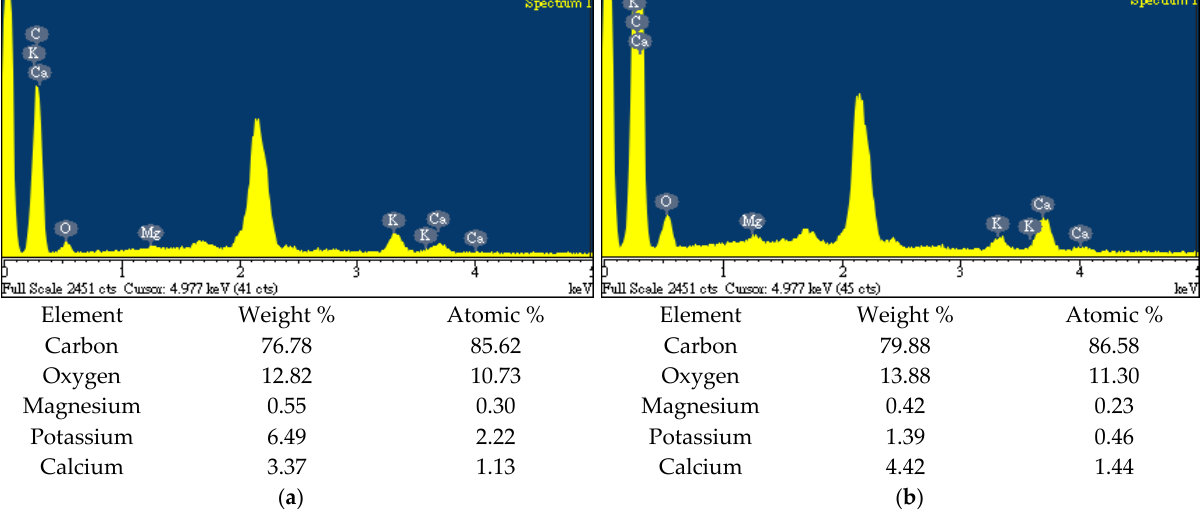
Figure 8. FTIR spectra of the biochar products (BC-SMC-SF-800 and BC-SMC-BF-800). 4. Conclusions In the present study, a series of biochar products were prepared from the spent mush- room composts (SMC, including shiitake fungus -SF and black fungus -BF) at various py- rolysis temperatures (i.e., 400, 600 and 800 °C). Obviously, these SMC samples had rela- tively high calorific values ( ˃ 20 MJ/kg), carbon contents (45.3 wt%), combustible values (76 – 77 wt%) and low ash contents (3.5 wt%), indicating that they could be excellent pre- cursor for producing biochar materials. The pore properties (i.e., surface area and pore volume) of the resulting biochar products were positively related to the pyrolysis temper- ature range (i.e., 400 – 800 °C). The values of the maximal BET surface area for the resulting biochar products produced at 800 °C (i.e., SMC-SF-BC-800 and SMC-BF-BC-800) were ob- tained at 312.5 and 280.9 m 2 /g, respectively. Based on the spectroscopic peaks of the EDS and FTIR, the highly porous biochar products had plentiful oxygen-containing functional groups on the surface, which could be excellent carbon materials in the water/wastewater treatment and soil amendment due to their polar nature (i.e., hydrophilicity and acidity). Author Contributions: Conceptualization, W.-T.T. and W.-S.C.; methodology, Y.-Q.L. and C.-H.T.; validation, Y.-Q.L.; data curation, Y.-Q.L.; formal analysis, Y.-Q.L.; resources, Y.-T.C.; writing —